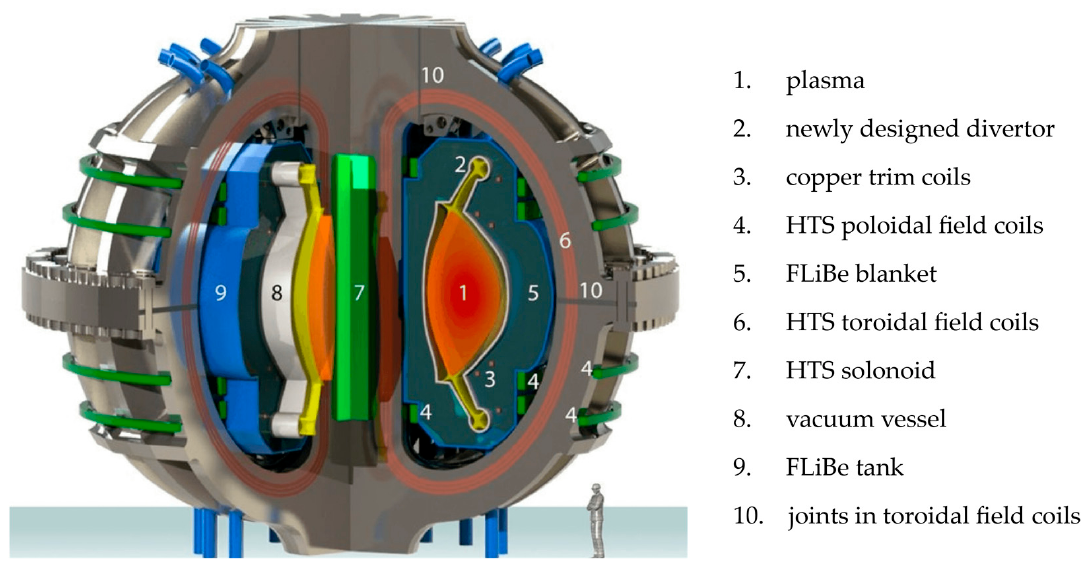
Figure 11. Conceptual design of the ARC reactor [27].